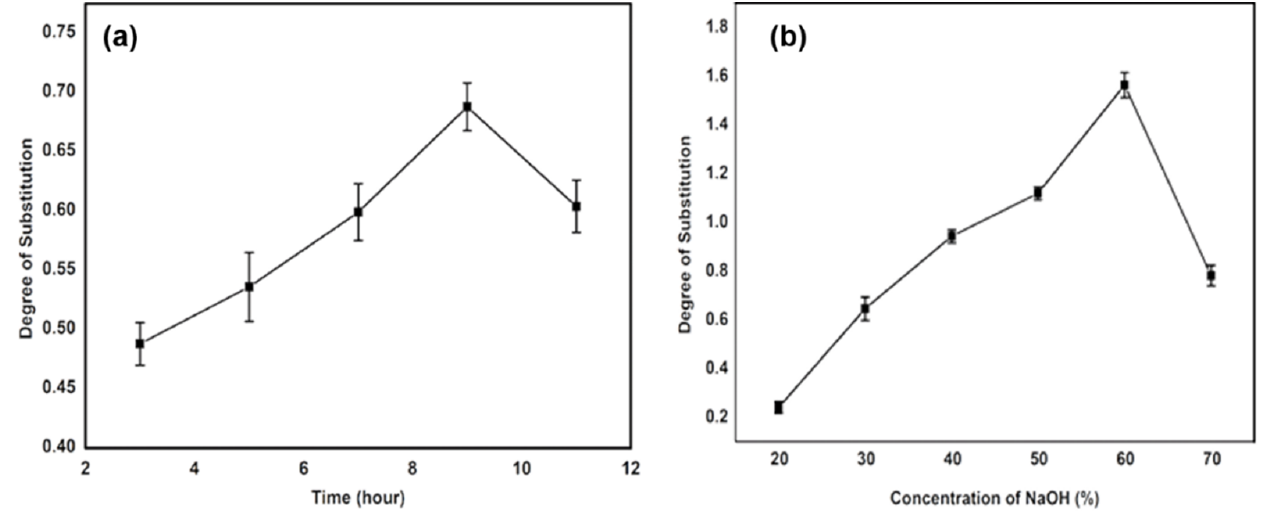
Figure 2. Effect of alkalization time on DS of OCMC in the presence of 30% NaOH ( a ) and Effect of NaOH concentration on DS of OCMC produced within 9 h ( b ).